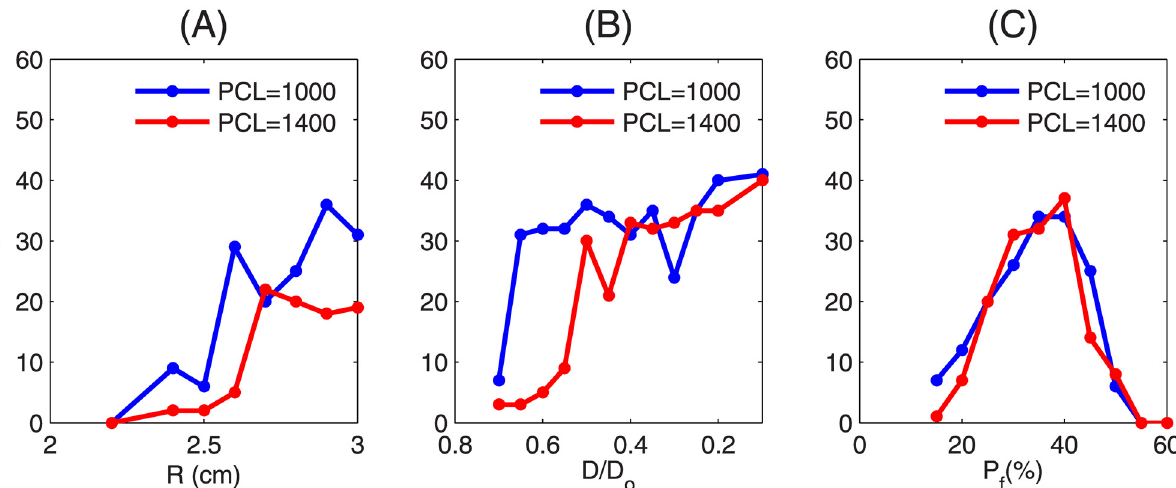
Fig 6. The dependence of the triggering of PVCs on the coupling strength of the EAD clump. The clumps in the top, middle, and the bottom panels have radii R = 2 cm. The clump with D = D o (top panel) does not trigger PVCs, whereas the clumps with D = 0.7xD o , (middle panel) and D = 0.2xD o (bottom panel) trigger PVCs. The clump with D = 0.2xD o supports small-wavelength spirals inside the clump as shown at times 6600 ms and 6620 ms.